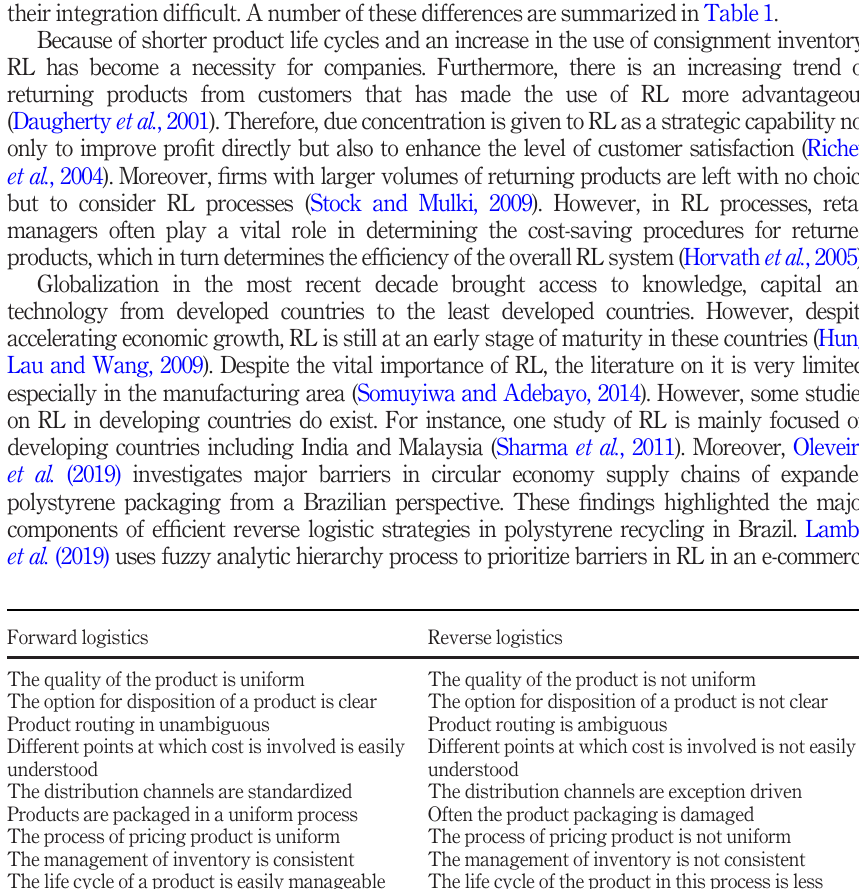
Table 1. Generalized form of the difference between the process of forwarding and reverse logistics